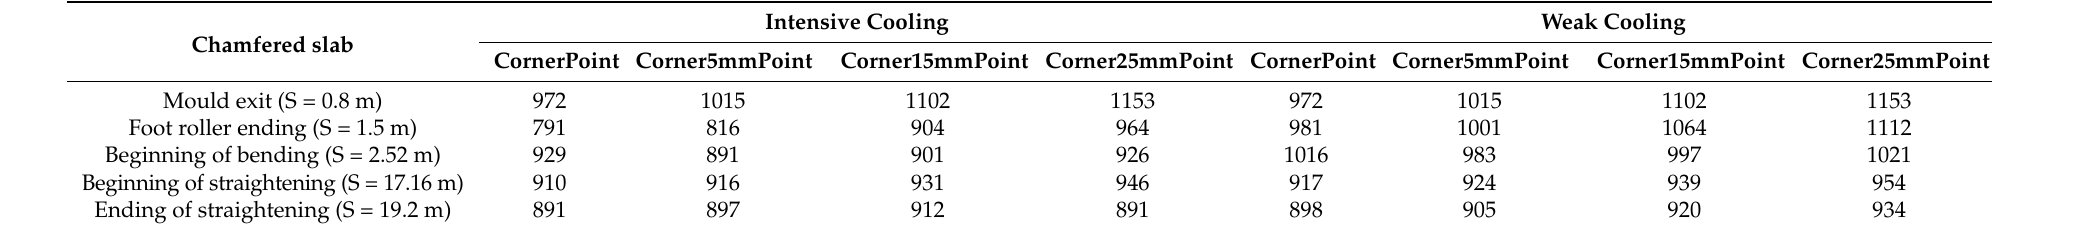
Table 6. Comparation of temperature of chamfered slab under intensive and weak cooling ( ◦